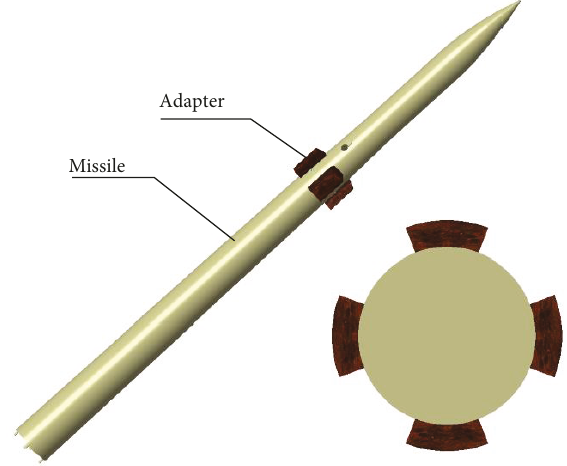
Figure 1: Layout of adapters on the